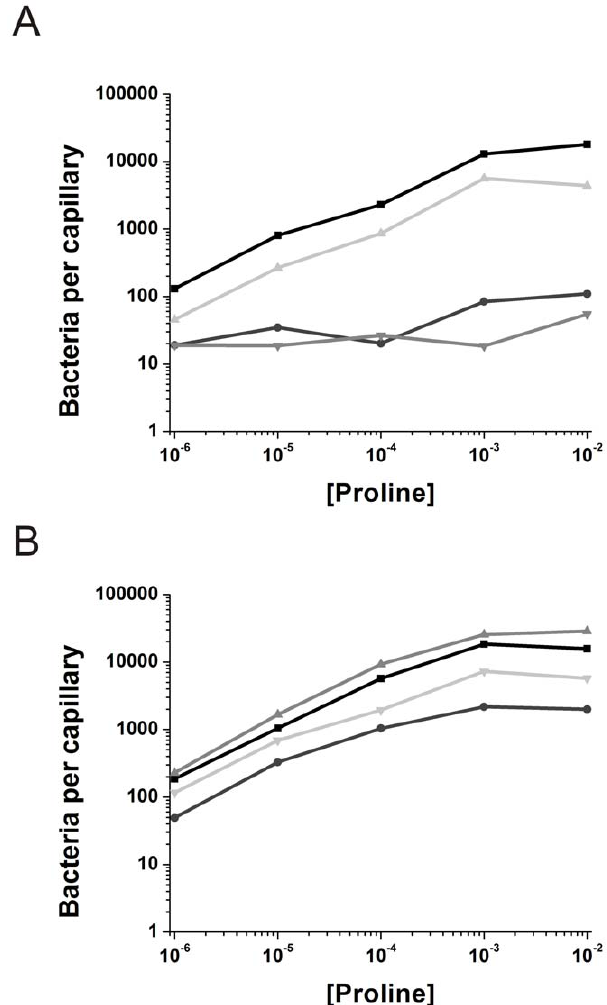
Figure 5. Capillary assays show reduced chemotactic ability in N various mutant strains. A. Wild-type OI1085 ( & ), cheD knockout ), cheD + pEB112:: cheD OI3142 ( m ) and cheD + pEB112:: cheD OI2934 ( (F102E) OI4488 ( . ). B. Wild-type OI1085 ( & ), cheC knockout OI3135 ( cheC amyE::cheC OI3165 ( m ) and cheC amyE::cheC (D149K) OI4172 ( . ). 1 mM IPTG was added to all the complementation